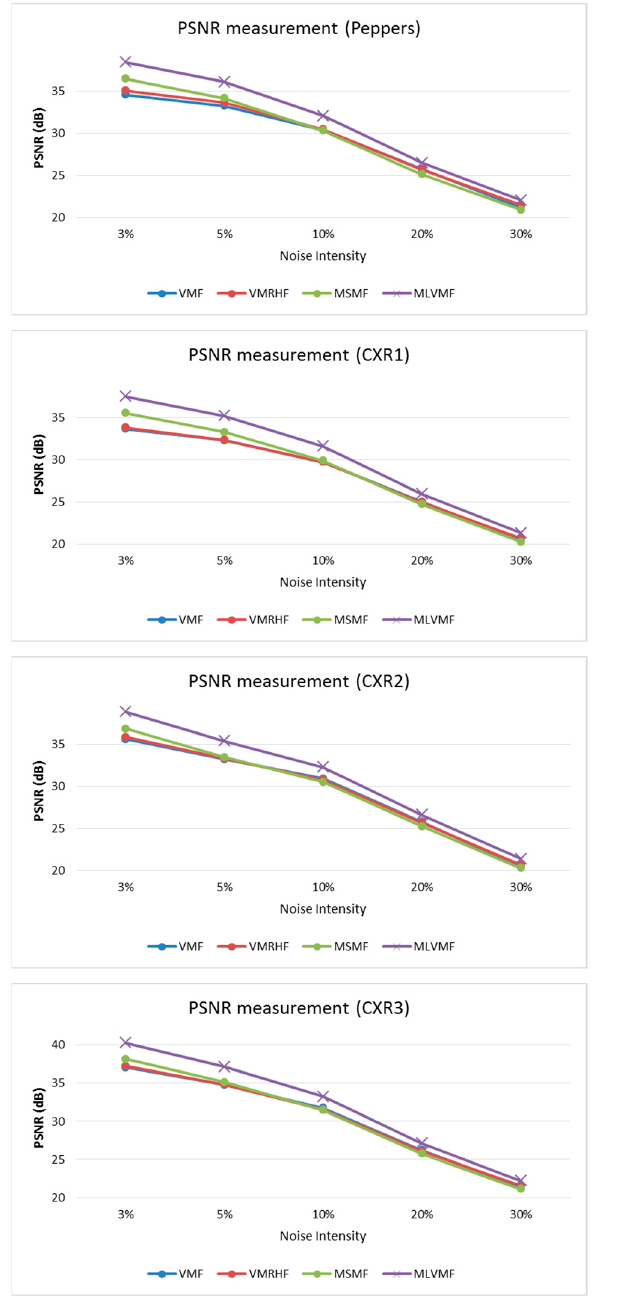
Figure 7. Performance comparison of the VMF, VMRHF, MSMF, and MLVMF filters using Lena, Peppers, CXR1, CXR2, and CXR3 images for various levels of impulsive noise. Left column: PSNR(dB) performance comparison. Right column: NCD performance comparison. Impulsive noise levels are: 3%, 5%, 10%, 20%, and 30%.